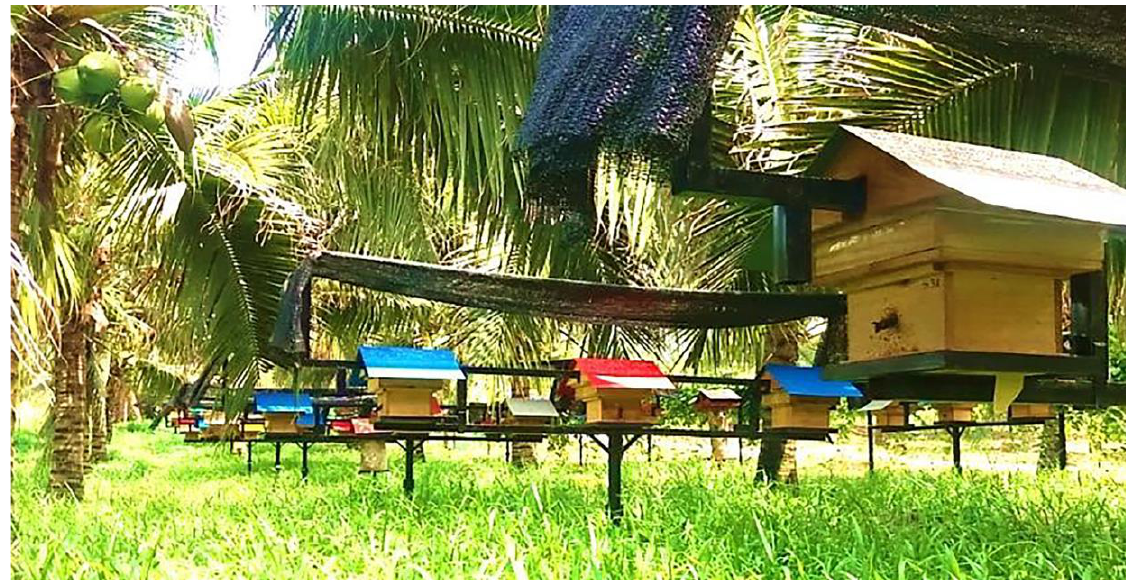
Figure 1. Mustafa-Hive system used by Malaysian farmers. Reprinted with permission from Ref. [10]. 2018, Penerbit Universiti Sains